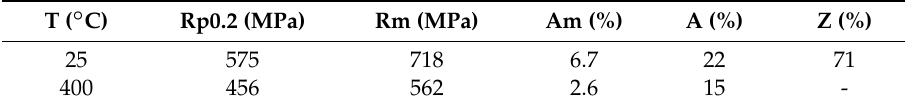
Table 2. Mechanical properties of the test material, where Rp0.2 is the yield strength, Rm is the ultimate tensile strength, Am is the deformation at maximum load, A is the fracture deformation, and Z is the reduction of